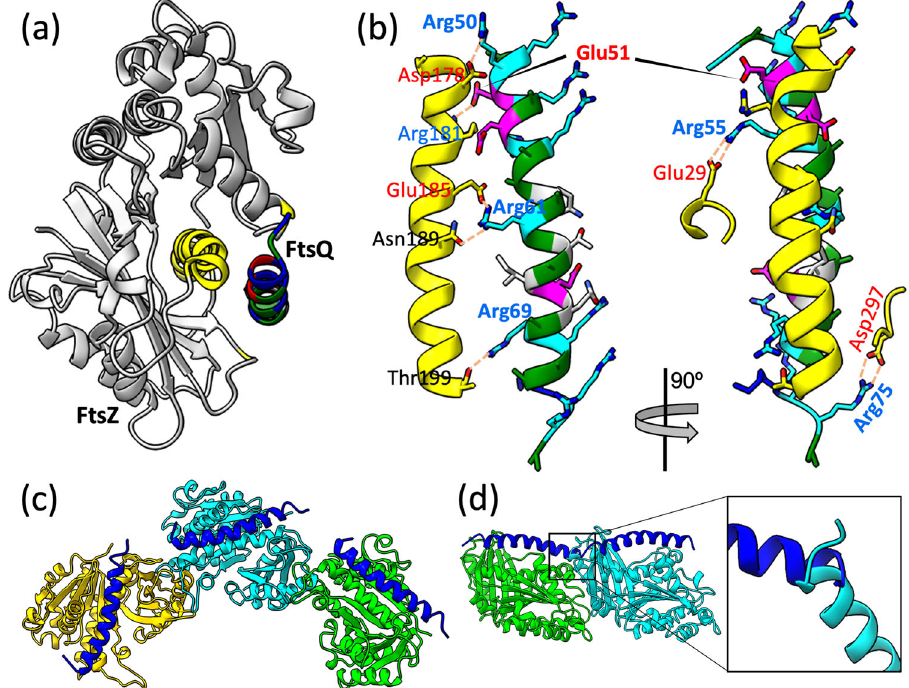
Fig. 8 Modeled complex between the FtsQ Arg/Ala-rich helix and monomeric or polymeric FtsZ. a The FtsQ helix docked to the GTPase domain of FtsZ (Protein Data Bank (PDB) entry 1RQ2 22 ). The FtsQ helix is shown with Arg, Ala, Glu, and other residues in blue, green, red, and gray, respectively. The FtsZ GTPase domain is shown in gray, except with yellow for the H7 helix at the base of the inter-subdomain cleft and two short segments at the entrance of the cleft. b Salt bridges and hydrogen bonds between the FtsQ helix and the inter-subdomain cleft of the FtsZ GTPase domain. c The FtsQ helix docked to a GTPase domain in a curved FtsZ polymer (PDB entry 4KWE 26 ), free of clashes with neighboring GTPase domains. d The FtsQ helix docked to a GTPase domain in a straight FtsZ polymer (PDB entry 1W5A 64 ), clashing with neighboring GTPase domains (see inset). a parallel direction with respect to the H7 helix and with an array FtsZ Asp178, FtsQ Glu51 with FtsZ Arg181, FtsQ Arg61 with of Arg residues, at positions 50, 61, and 69, within the interface FtsZ Glu185 and Asn189, and FtsQ Arg69 with FtsZ Thr199. The (Fig. 8b, left panel). A number of salt bridges and hydrogen bonds Arg/Ala-rich helix also forms two additional salt bridges with the are formed between the two helices, including FtsQ Arg50 with walls of the cleft, i.e., between FtsQ Arg55 and FtsZ Glu29 on one COMMUNICATIONS BIOLOGY| (2023) 6:311